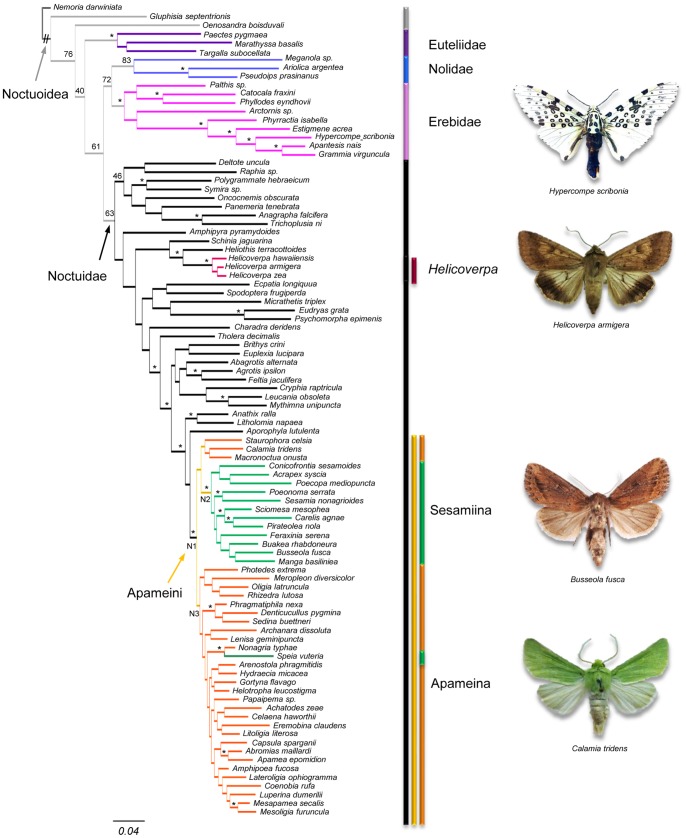
Phylogenetic relationships of the tribe Apameini within the superfamily Noctuoidea under Bayesian inference.Posterior probabilities (PP) are indicated above the nodes (* indicates a value up to 0.95). When no values are indicated, it means that the PP was <0.95, except for some basal nodes for which the support is annotated. Groups of interest are highlighted by vertical bands of different colours referring to the colour of the clades. The Apameini, Sesamiina and Apameina (excluding the three genera Staurophora, Calamia and Litholomia) nodes are respectively labelled N1, N2 and N3. Names of the species for which a habitus is displayed are specified under the pictures (Pictures: EFA Toussaint & BP Le Ru).